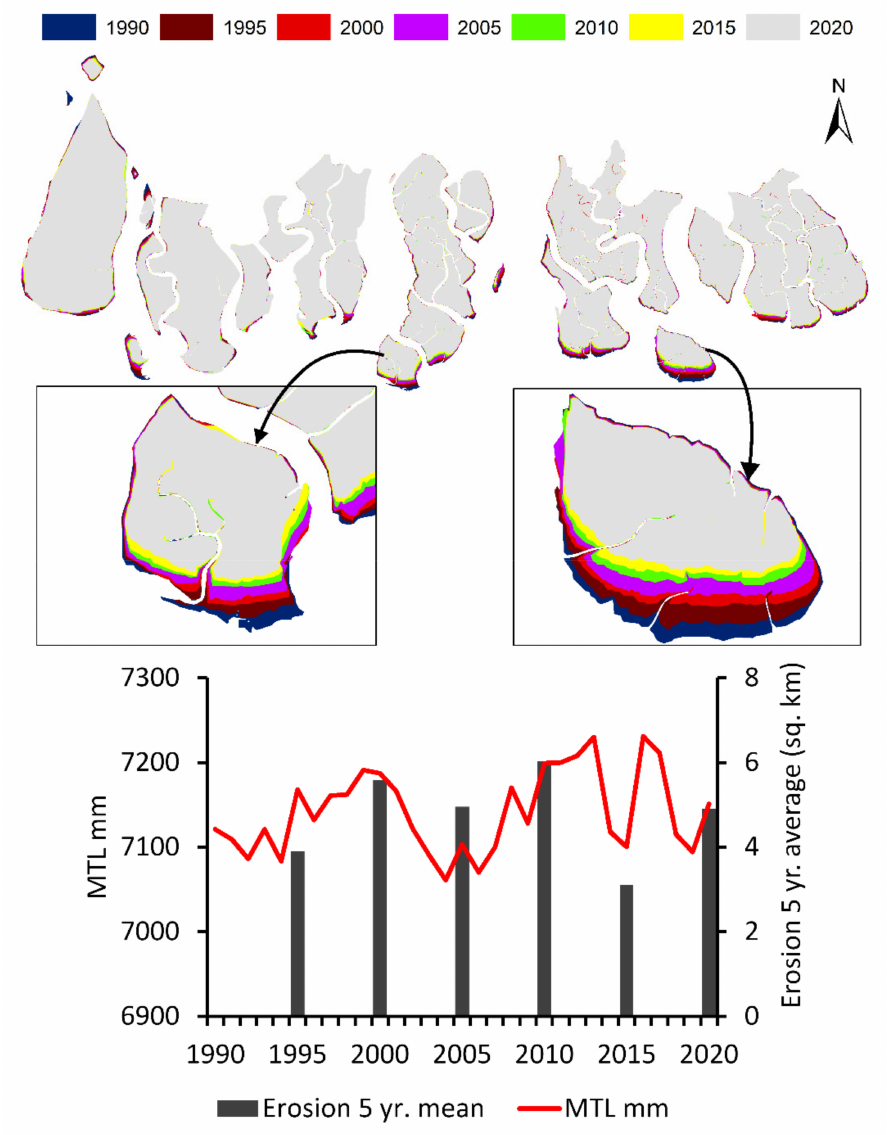
Figure 7. Relationship between sea-level rise and loss of mangrove island area due to erosion. MTL stands for mean tide